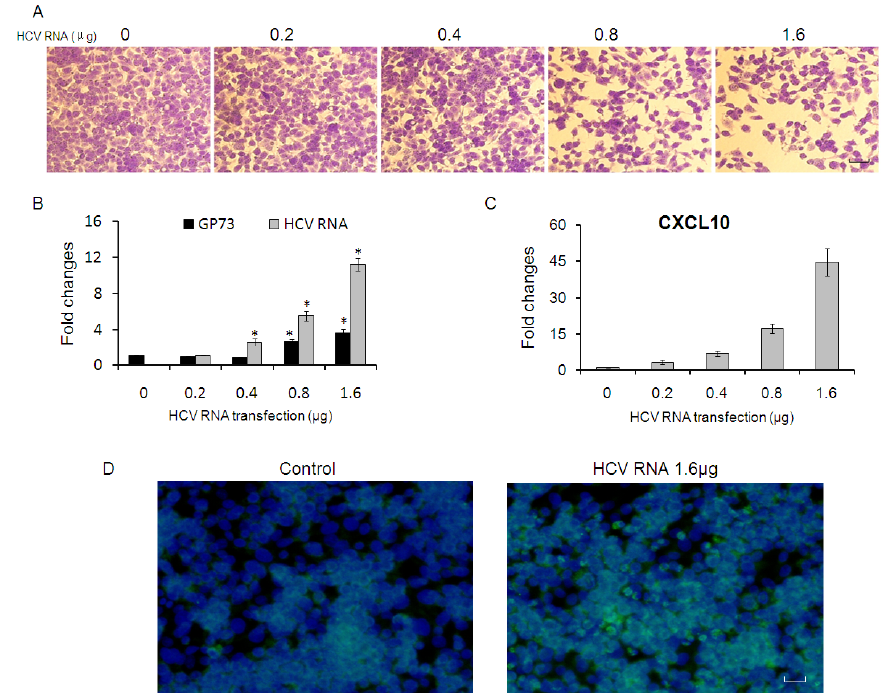
Figure 4. HepG2 cells were transfected with 0, 0.2, 0.4, 0.8 and 1.6 µg of HCV RNA.